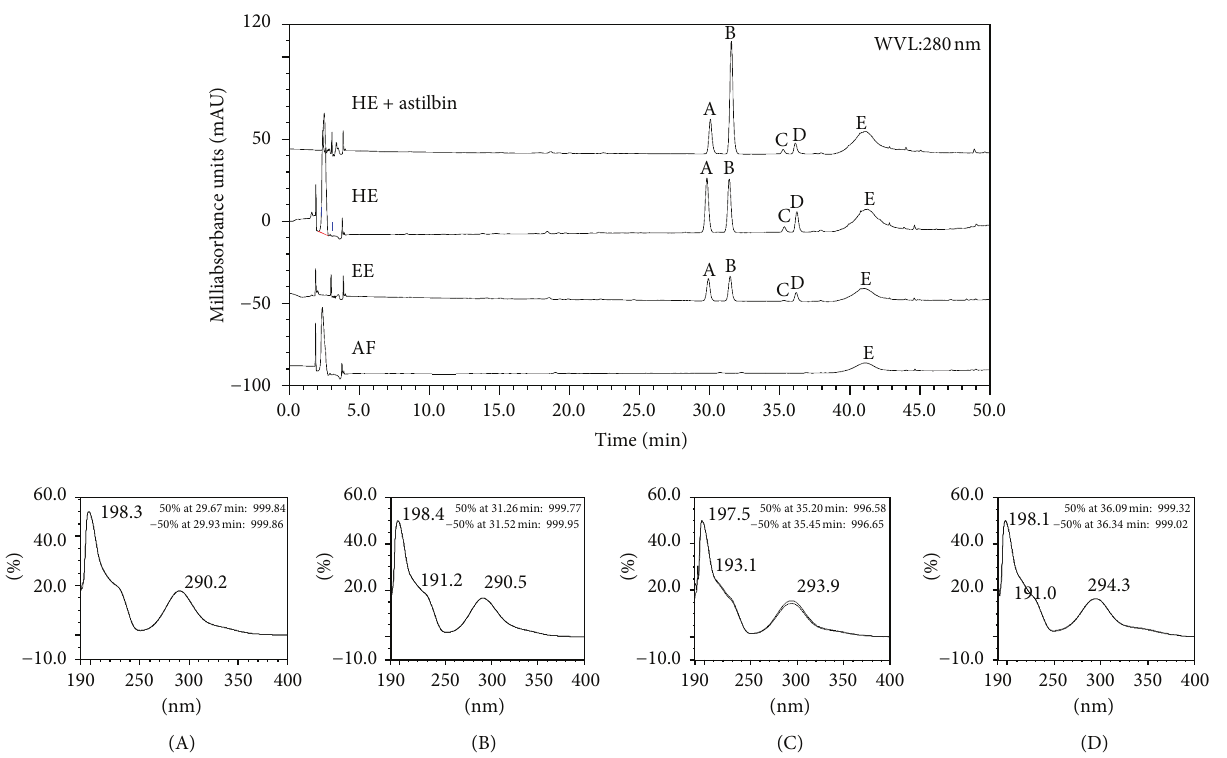
Figure 1: Chromatographic fingerprints from Hymenaea stigonocarpa stem barks. Hydroalcoholic extract (HE) + astilbin (98%), hydroalcoholic extract (HE), ethanolic extract (EE), and aqueous fraction (AF) obtained by HPLC DAD at 280 nm. Each chromatographic peak appears with its corresponding retention time. UV spectrum pattern derivatives flavonoids (A, C, and D) identified as astilbin